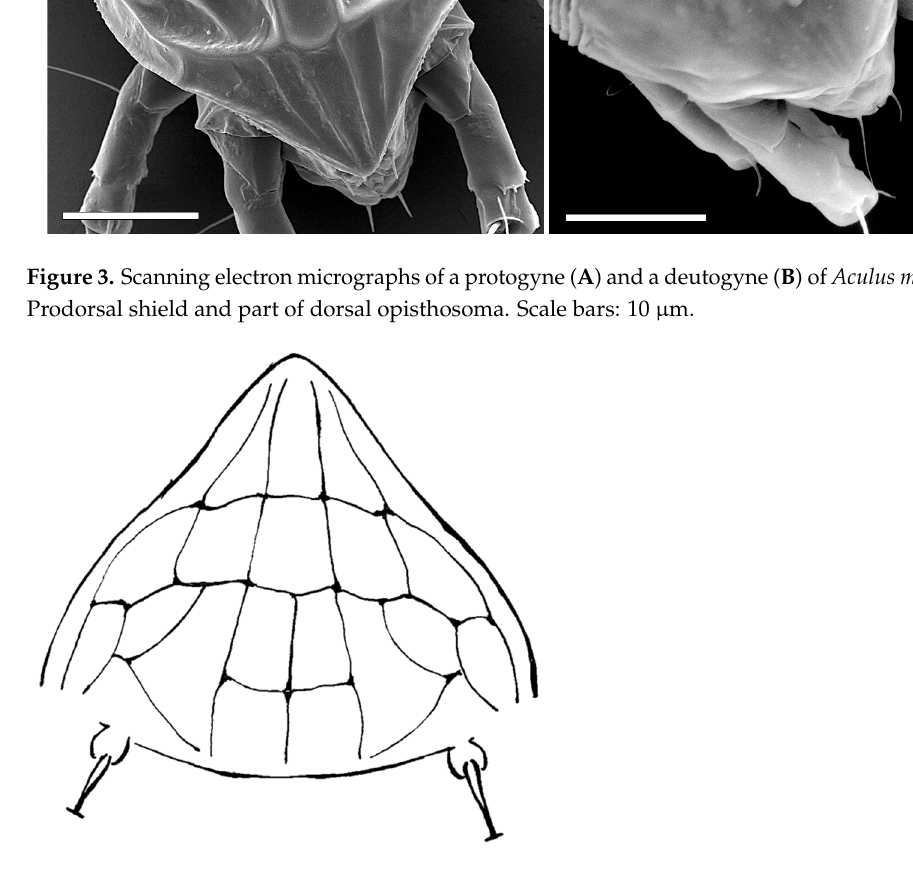
Figure 4. Line drawing of the prodorsal shield of Aculops taihangensis paratype.